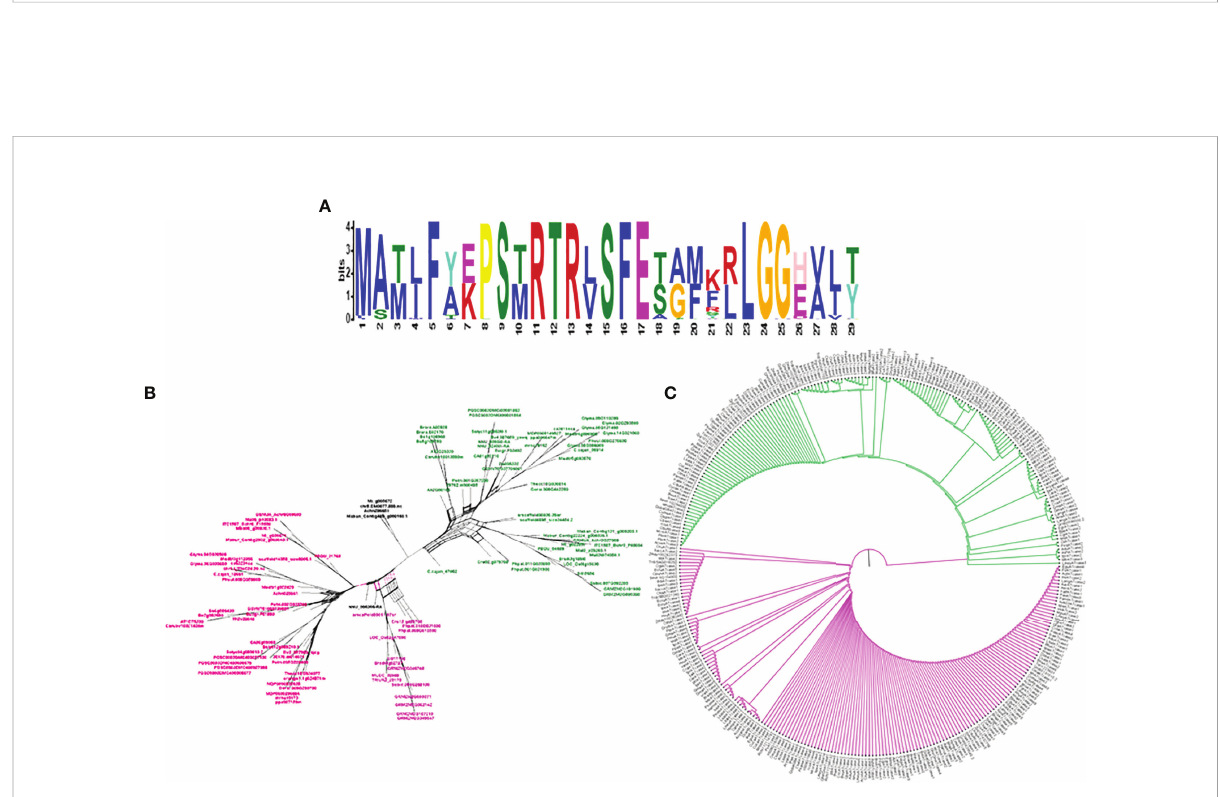
FIGURE 4 The logo representation of conserved motif (A) in carbamoyltransferase domain of plant groups and phylogeny (C) and network (B) of the same, representing the signature distribution of 2 different classes of carbamoyltransferase: aspartate carbamoyltransferase (Pink) and ornithine carbamoyltransferase